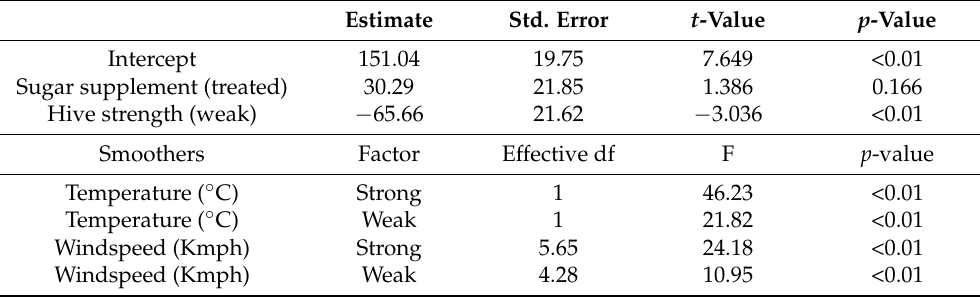
Table 1. Estimated regression parameters, standard errors, t-, and p -values for the Gaussian gener- alized additive mixed model conducted to compare bee activity for hive strength (strong/weak) based on colony size and to compare a sugar syrup supplement treated with chlorine versus no chlorine as a factor. Smoothing terms included climate variables for temperature and windspeed for each level of the hive strength factor.